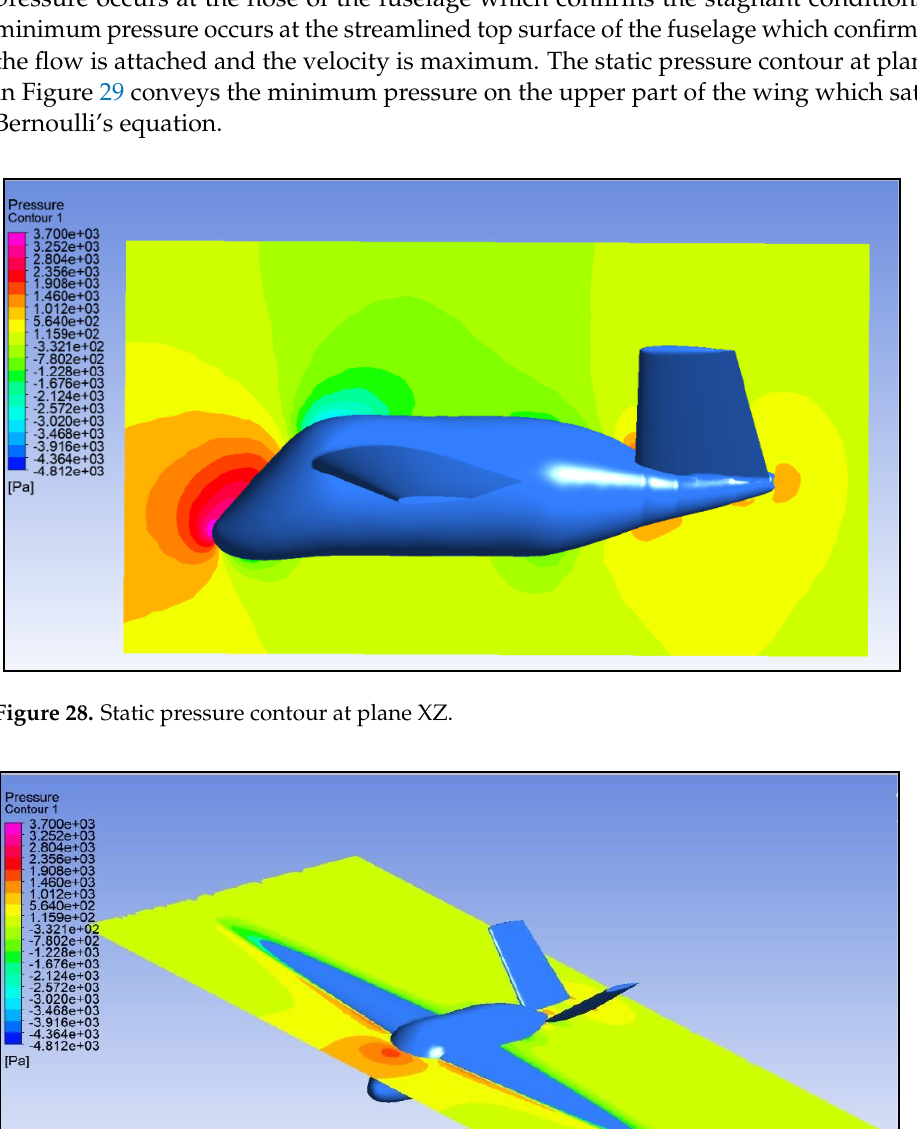
Figure 27. Total pressure contour.